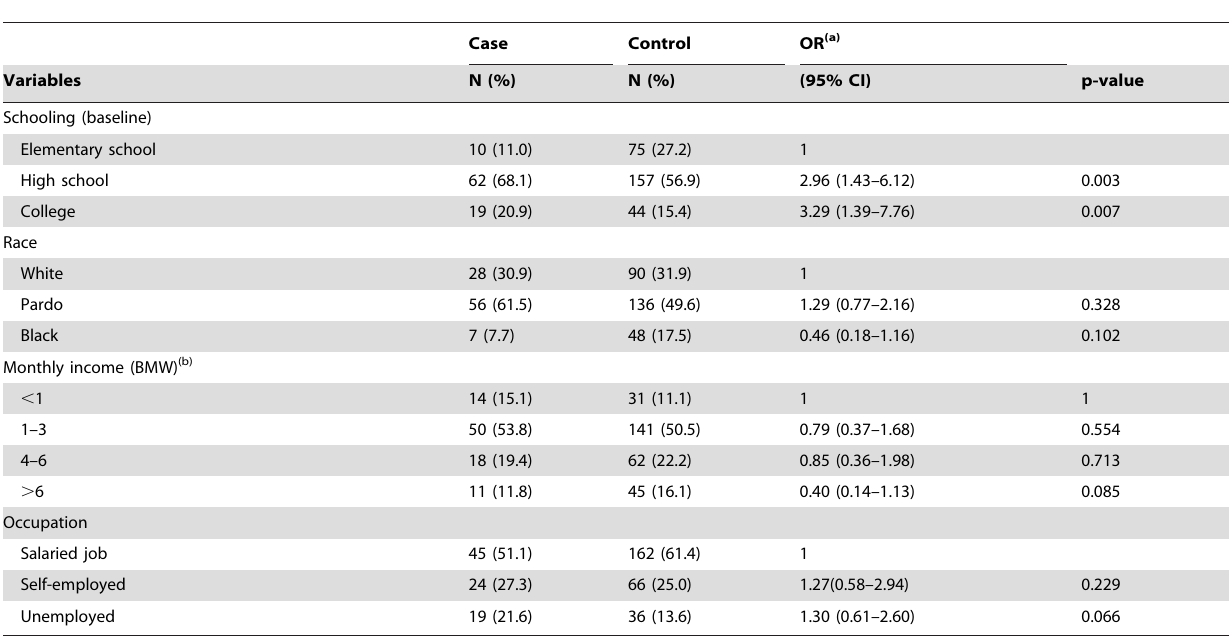
Table 1. Univariate analysis of the sociodemographic characteristics comparing HIV-positive cases and HIV-negative controls, Project Horizonte,